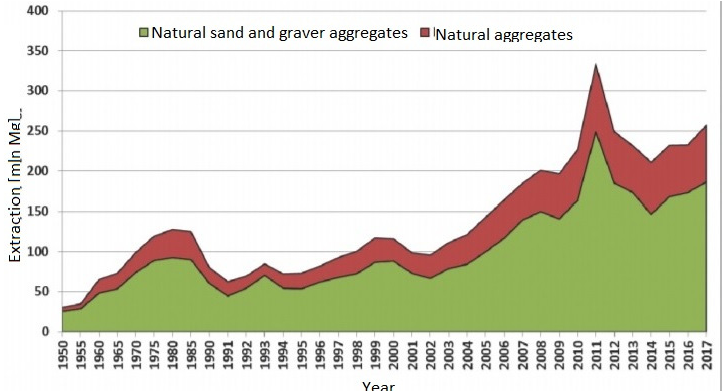
Figure 1. Sand consumption in Poland between 1950 and 2017 [19].